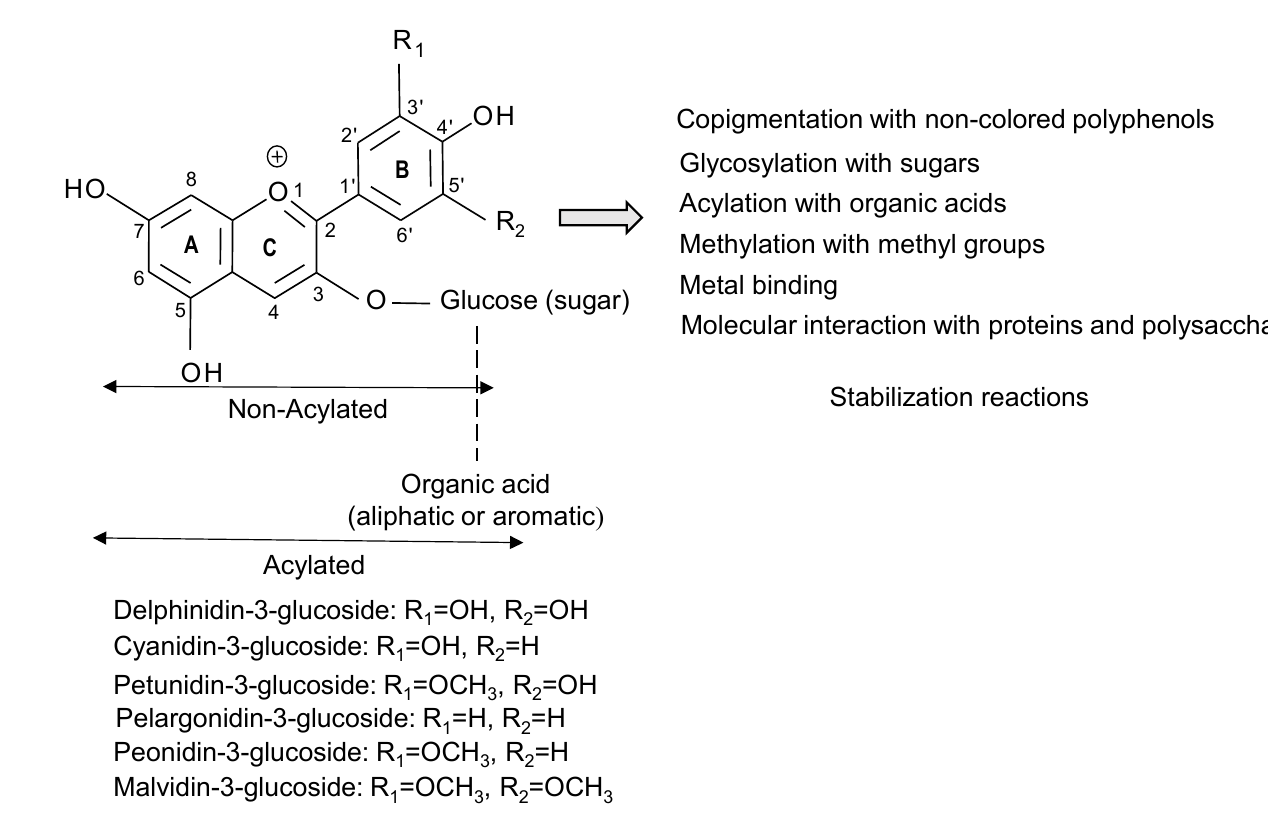
Figure 1. Structures of common anthocyanidins, their anthocyanins-3-glucoside, and possible stabi- lization reactions.